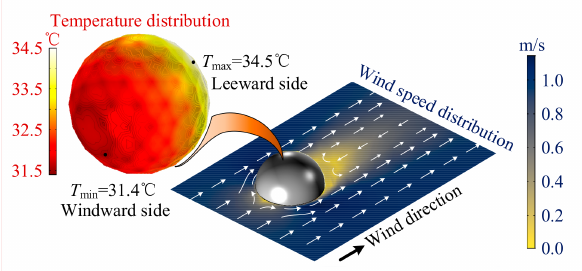
Figure 10. Steady-state calculation results of FE model with V w = 1 m / s.